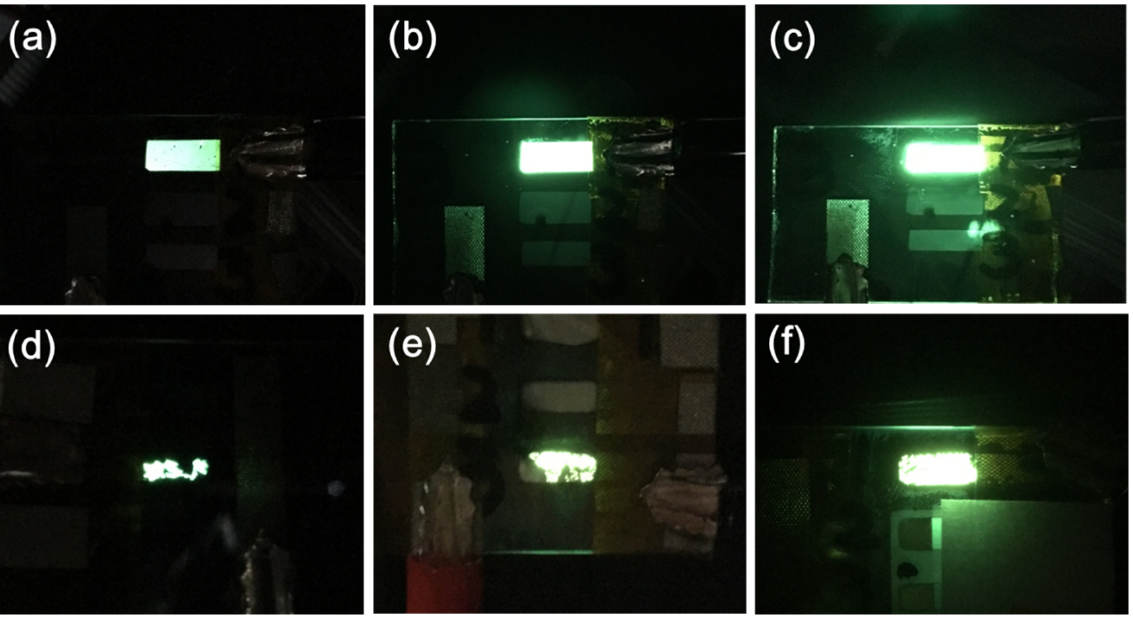
Figure 6. Images of the same OLED (CNT solution: 0.2 mg/mL) under different voltages at time t = 0: ( a ) 4 V, ( b ) 8 V, and ( c ) 20 V. Images of OLEDs with different CNT solution concentrations of ( d ) 0.0 mg/mL, ( e ) 0.2 mg/mL, and ( f ) 1.0 mg/mL driven at 8 V after t = 4 h, under ambient conditions.